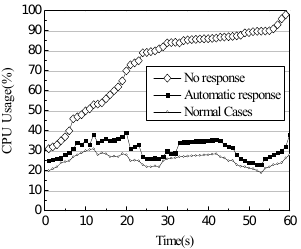
Fig. 3. The CPU utilization comparison of three cases Compared with Fig. 2 and Fig. 3, network traffic